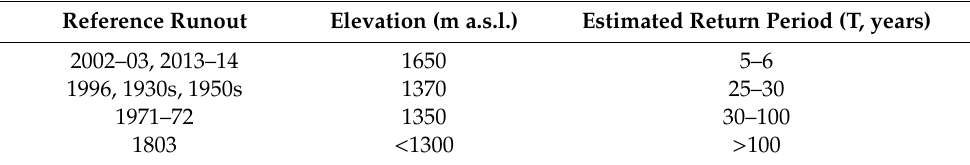
component of the